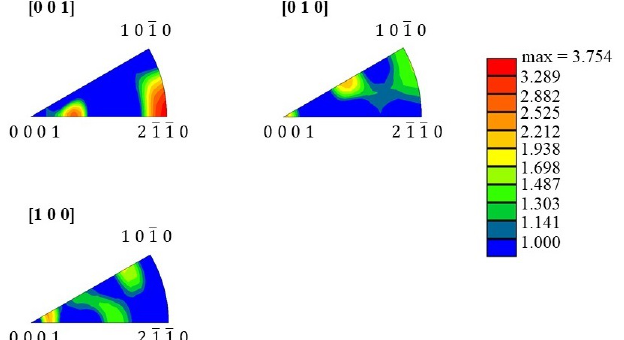
Figure 5. Inverse [001], [010] and [100] pole figures of WAAM-fabricated Ti-6Al-4V with an intensity maximum of H max = 3.754 mrd. The directions of [001], [010], and [100] are parallel to the transverse, normal and longitudinal directions of the specimen,